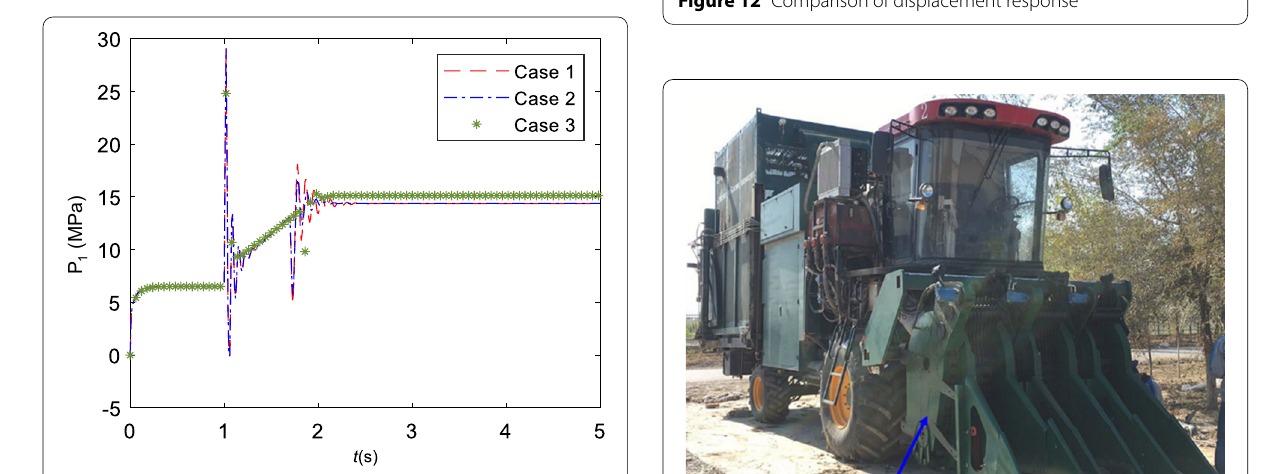
Figure 11 Pressure comparison of the three cases